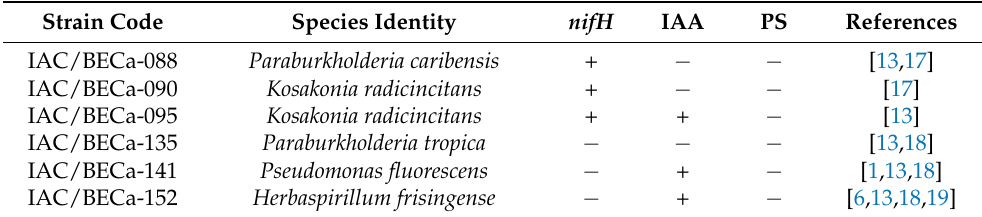
Table 1. Plant growth-promoting substances production (+) or not ( − ) by endophytic bacteria according